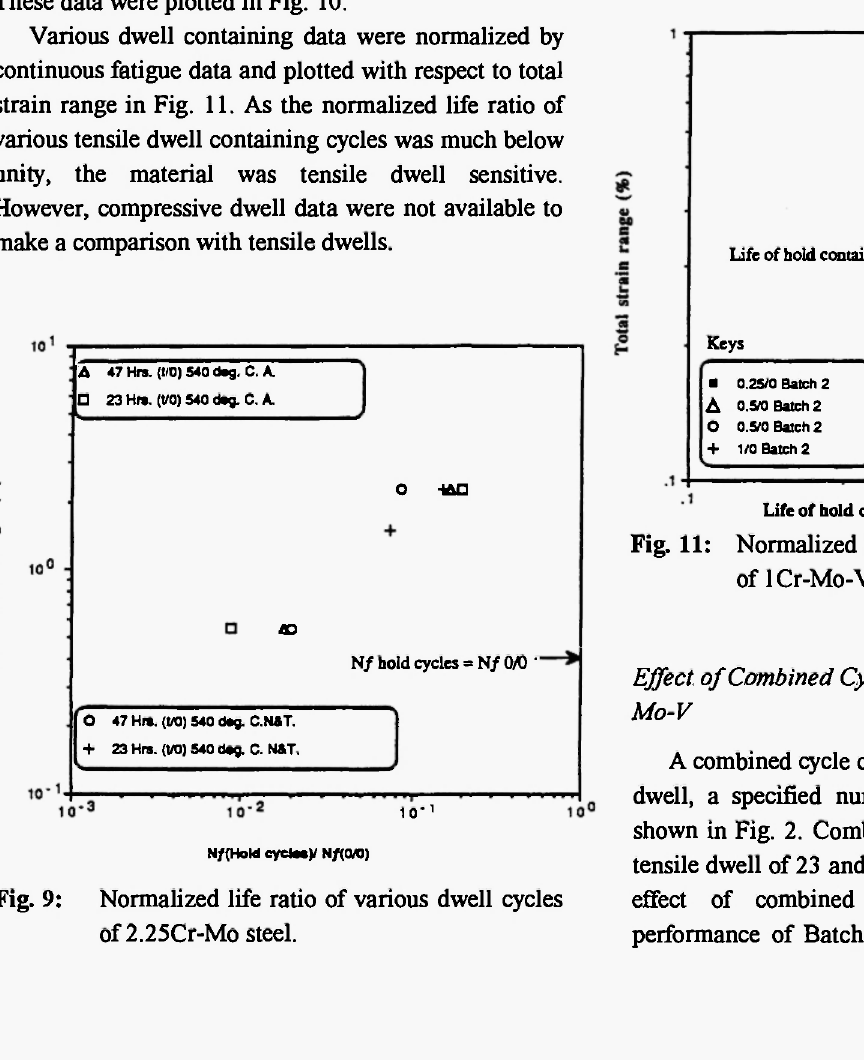
Cydic life Fig. 10: Creep-fatigue behavior of 9Cr-lMo steel with different hold times.